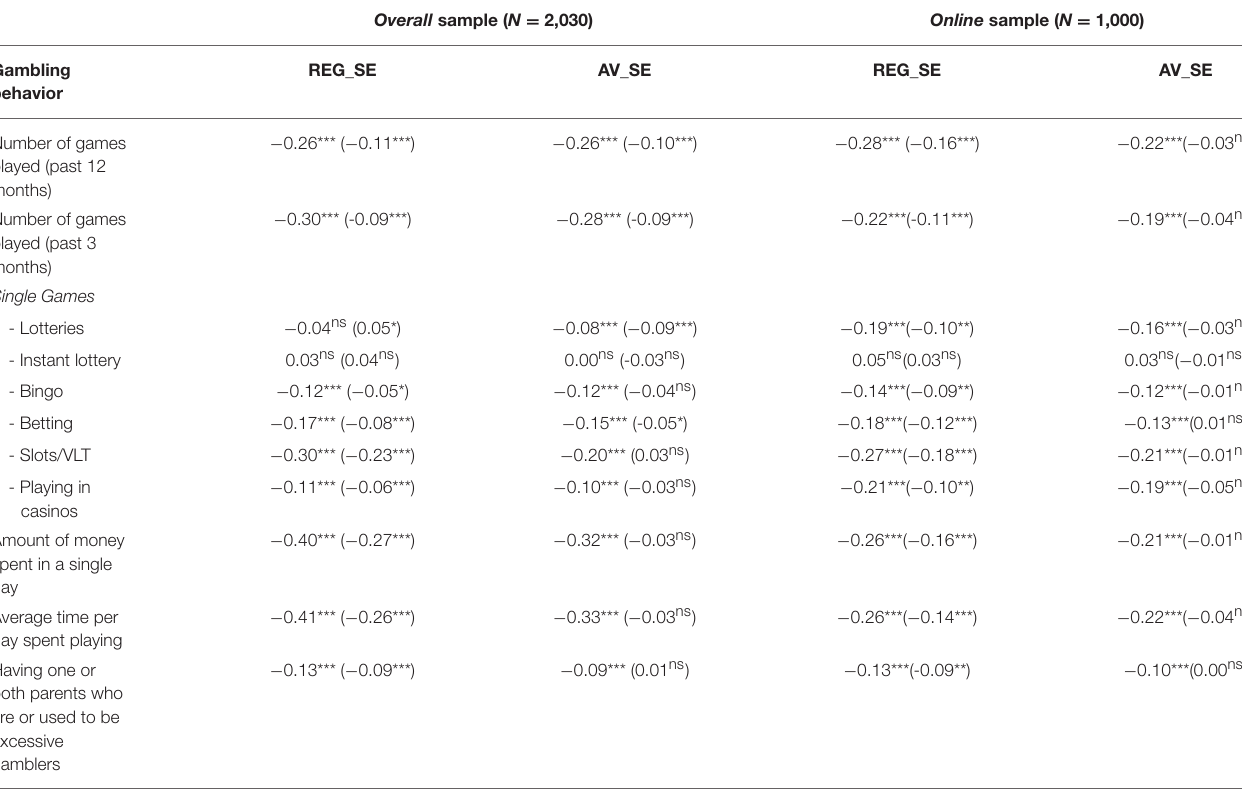
TABLE 6 | Zero-order correlations and partial correlations (within parentheses) of MGSES dimensions with measures of gambling behaviors. Overall sample ( N =